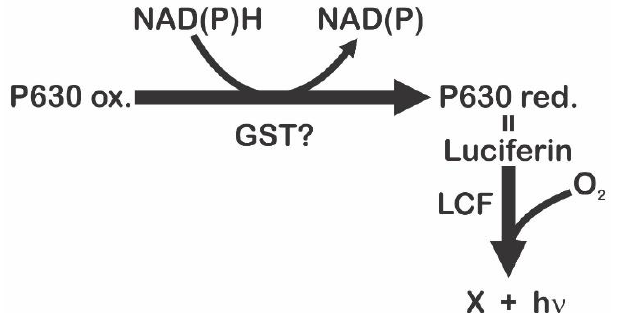
Figure 10. Light emission process proposed by Fresneau et al. (1986) which is controlled by at least two successive reactions, where in the first the reduction of the luciferin precursor P630 is carried out by a NAD(P)H-dependent reductase, maybe GST, and in the second, the emission of light is carried out by LCF.